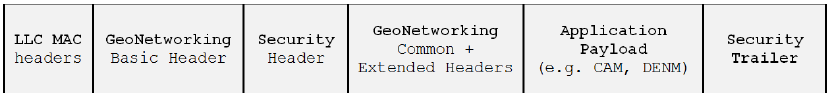
Figure 4. Secured GeoNetworking packet structure as defined in ETSI TC